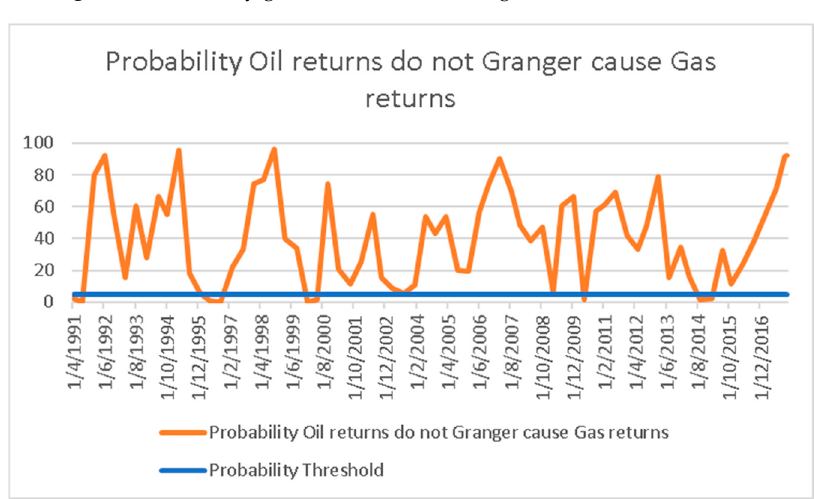
Figure 3. Probability gas returns do not Granger cause oil returns (in %).